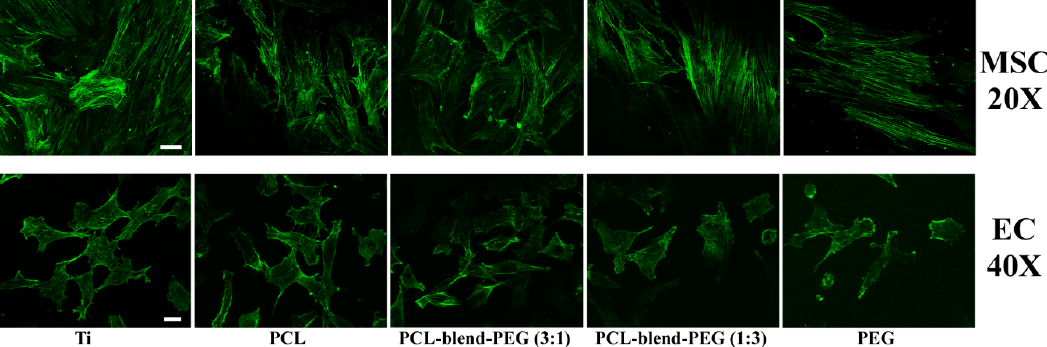
Figure 11. Fluorescence microscopy images of mesenchymal stem cells (upper panel) and endothelial cells (lower panel), adhesion after 9 and 3 days, respectively, seeded on PCL-blend-PEG coatings deposited by DC. Actin filaments were labelled with Alexa Fluor 488-conjugated Phalloidin (green) (upper panel 20×; scale bar = 50 μ m; lower panel 40×; scale bar = 20 μ m).